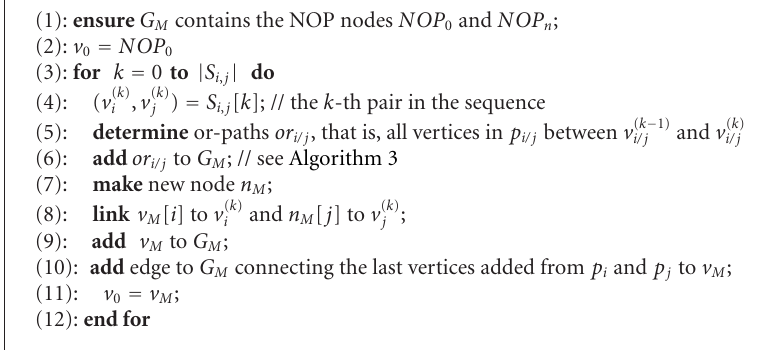
Algorithm 2. When no further paths with similarities exist, the remaining paths are added to the merge graph (line